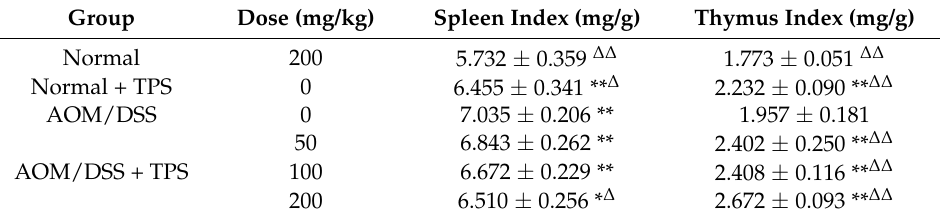
Each data point represents the mean ± SD of six animals for each group. * p < 0.05, ** p < 0.01, vs. Normal mice. ∆ p < 0.05, ∆∆ p < 0.01 vs. AOM/DSS mice.